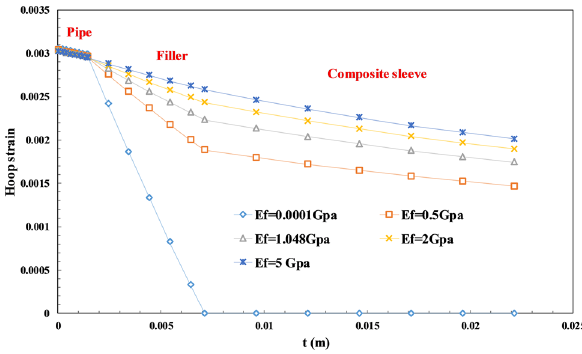
Fig. 23 3-D diagram of the burst pressure versus 𝜇 1 and 𝜇